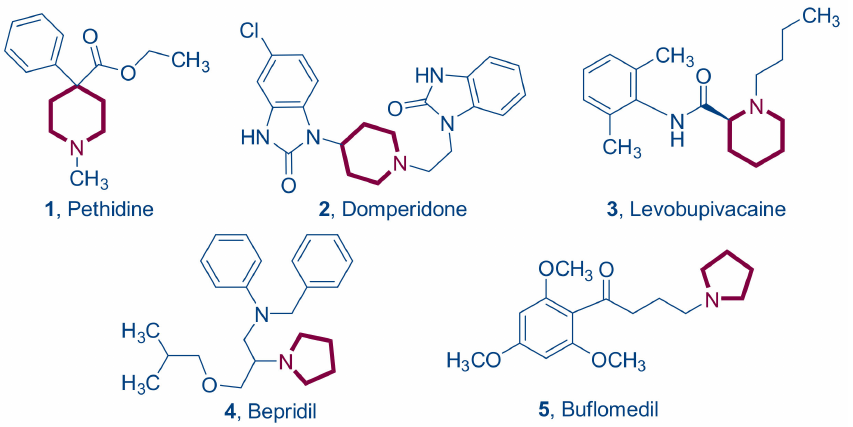
Figure 1. Drugs containing piperidine or pyrrolidine